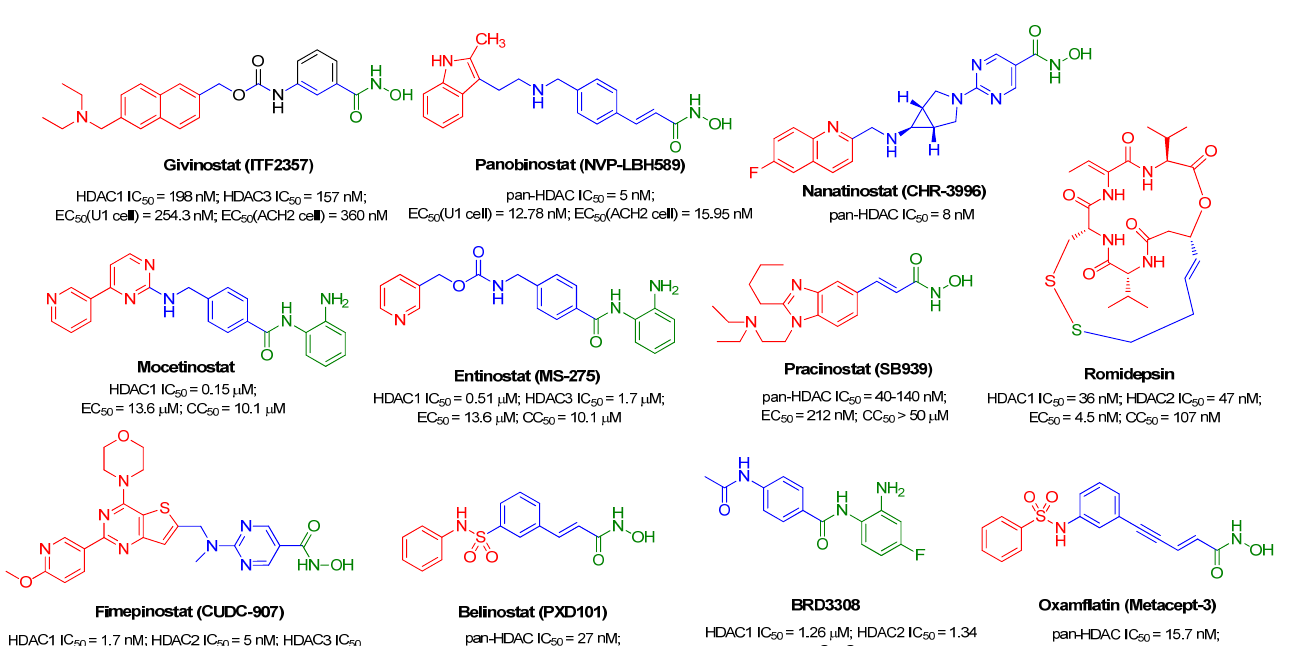
Figure 3. Several pan-HDACIs or class I-selective HDACIs that have entered various clinical trials for anticancer purposes were also submitted to the anti-latency evaluations.